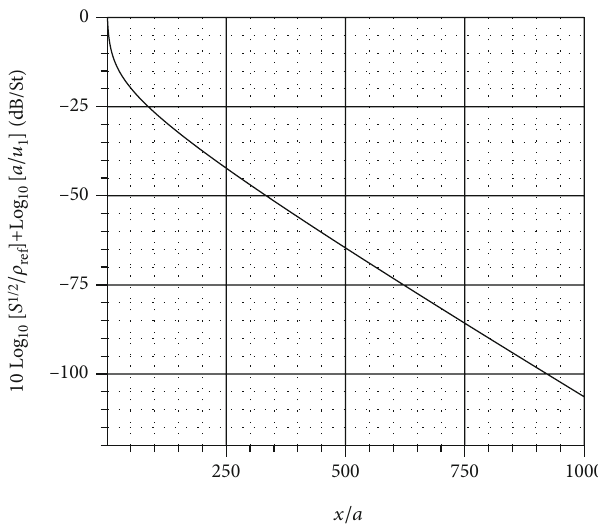
Figure 5: The power spectrum of density at 20 Hz as a function of x / a